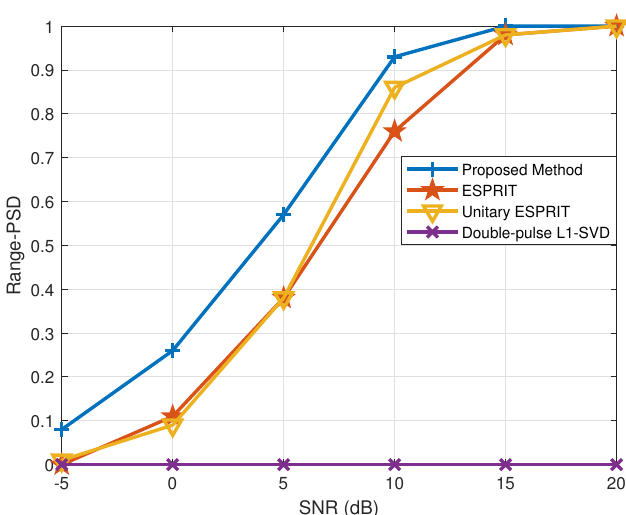
Figure 10. PSD of range estimation versus